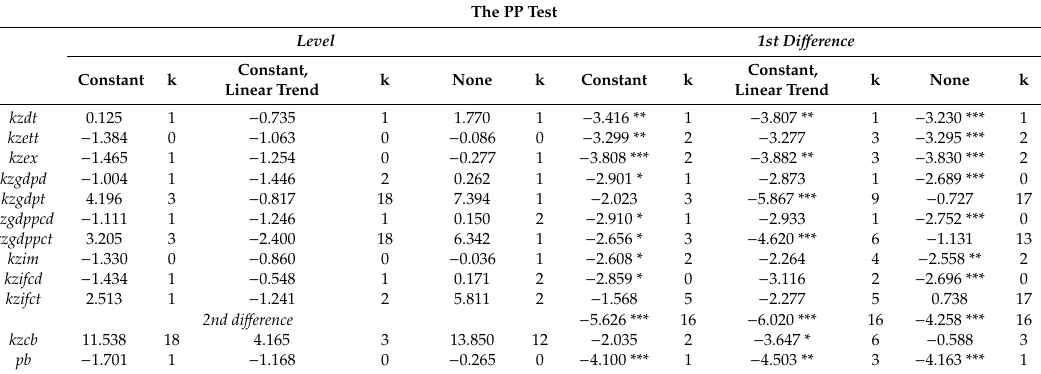
Table A24. KZ. The Unit Root test results.